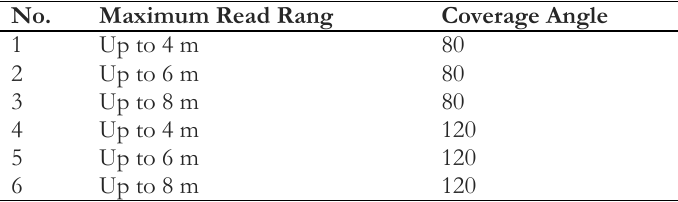
Table 3. Parameter setting for the GA-SA